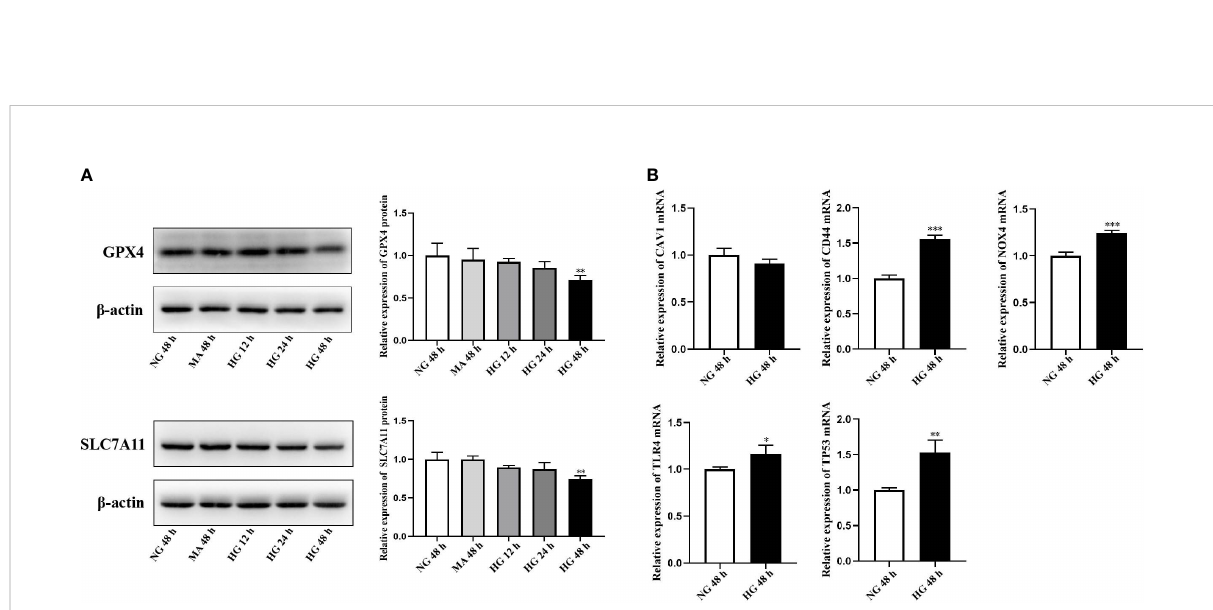
FIGURE 8 External validation of GPX4, SLC7A11 and ferroptosis-related hub genes (FRHGs). (A) The protein levels of GPX4 and SLC7A11 were evaluated in cell samples by western blot. (B) The mRNA levels of CAV1, CD44, NOX4, TLR4, and TP53 were evaluated in cell samples by qRT-PCR. NG, normal control group; MA, Mannitol; HG, high-glucose group. * p < 0.05 vs NG 48 h, ** p < 0.01 vs NG 48 h, *** p < 0.001 vs NG 48